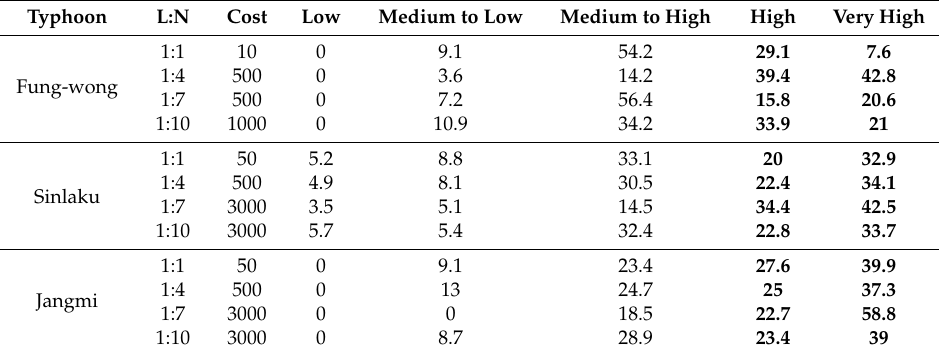
Figure 9. Comparison of the representative results ( Y axis: accuracies) of Typhoon Jangmi prediction using the RF, DT, BN, and logistic algorithm with cost-sensitive analysis, where RF, DT, BN, OA, UA, PA, AUC, L, and N indicate random forests, decision tree, and Bayes network algorithm, overall accuracy, user’s accuracy, producer’s accuracy, area under ROC curve, landslide class, and non-landslide class, respectively.( a ) L:N = 1:1; ( b ) L:N = 1:4; ( c ) L:N = 1:7; ( d ) L:N = 1:10. Table 4. Landslide susceptibility distributions (Unit: %) of the single-event occurrence samples based on the RF algorithm with cost-sensitive